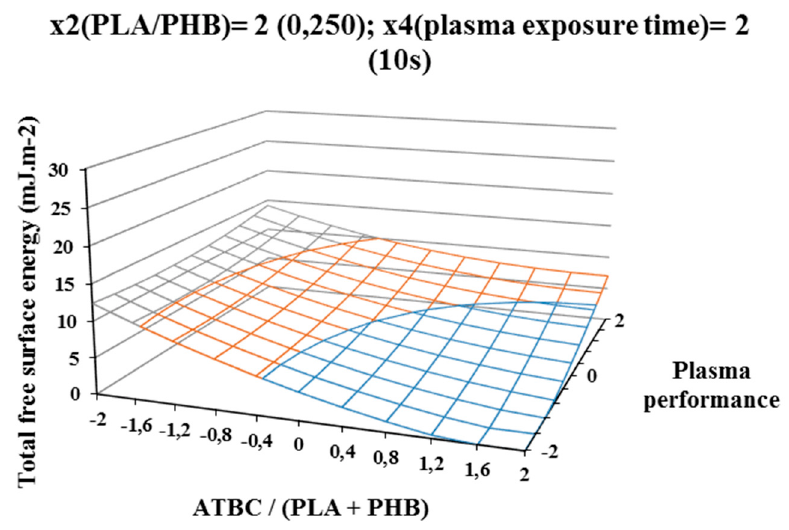
Figure 7. Response surface of difference of the polar component of free surface energy measured immediately after plasma surface treatment in dependence of factors x1 (ATBC / (PLA + PHB)) and x3 (plasma power) at constant factor x2 (PHB / PLA) = 2 and x4 (plasma exposure time)) = 2 .